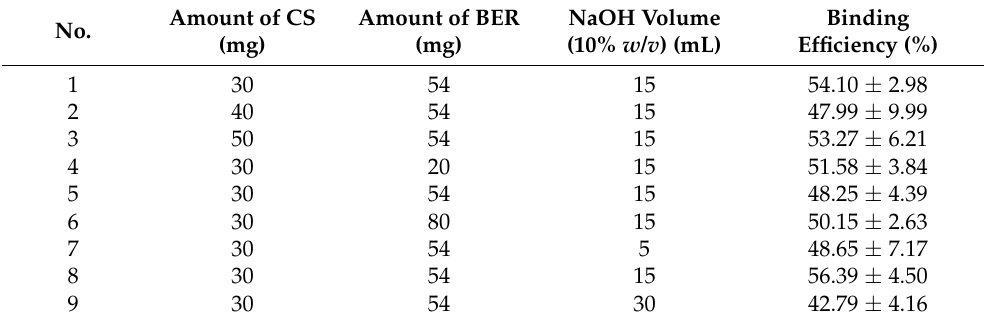
Table 1. Binding efficiency of BER/CS ( n = 3).